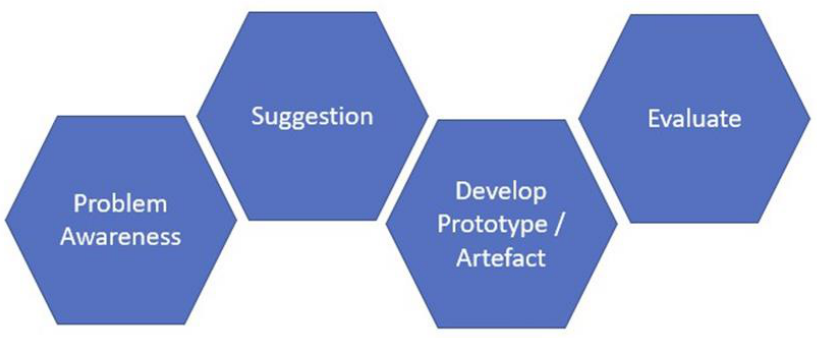
Figure 1. Research strategy based on design science research as suggested in [14].